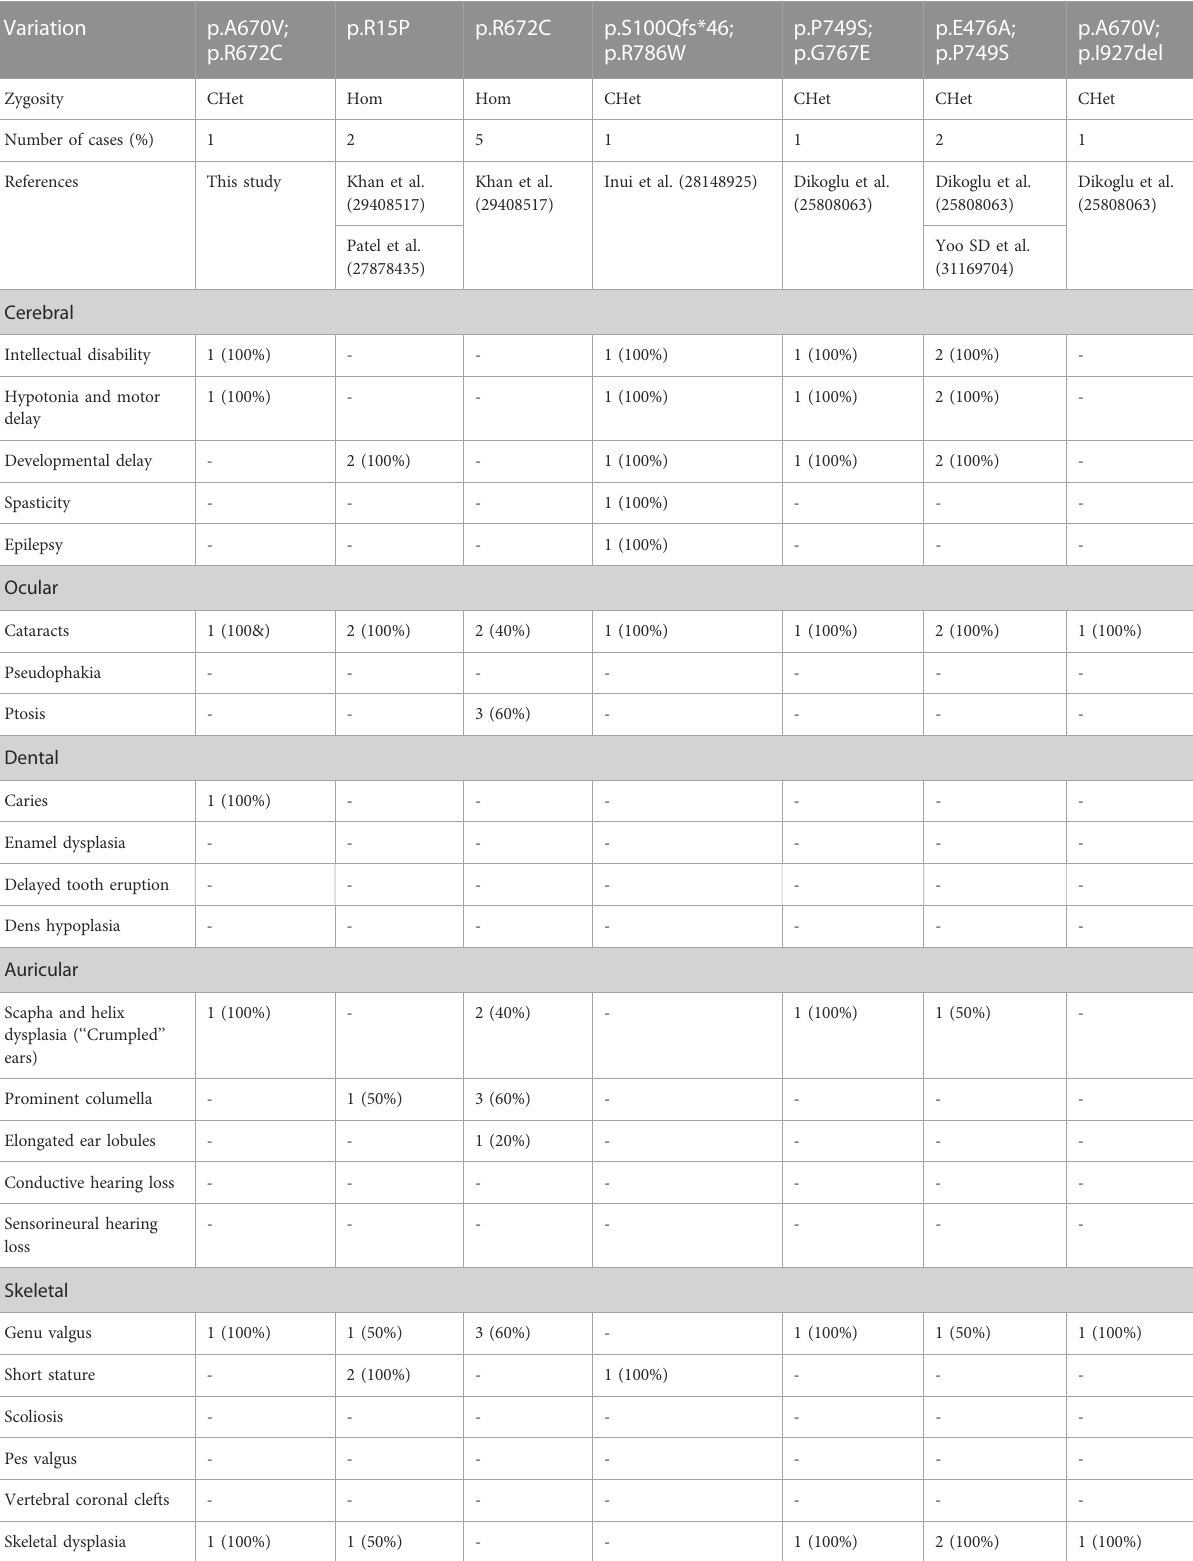
TABLE 1 The summary of reported LONP1 variants in patients with CODAS syndrome. Variation